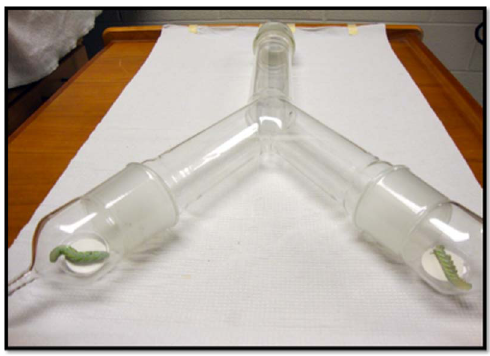
Figure 1. Y-tube olfactometer using live and dead caterpillars. The olfactometer is 70 6 35 6 6 cm with the two upwind arms being supplied with charcoal-purified air at a rate of 0.75 litre/sec.